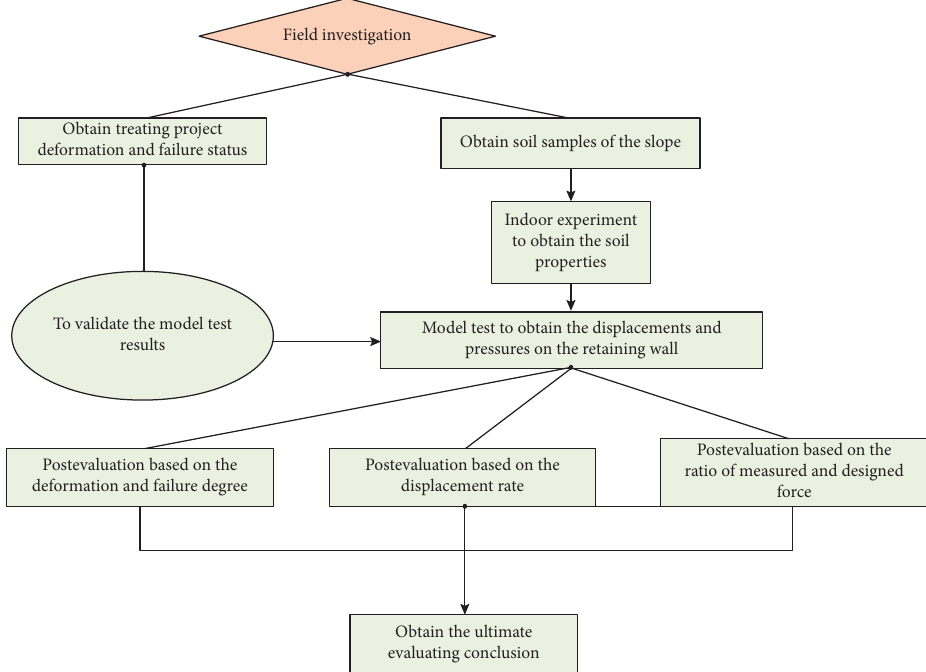
Figure 18: Postevaluation frame for retaining wall treating